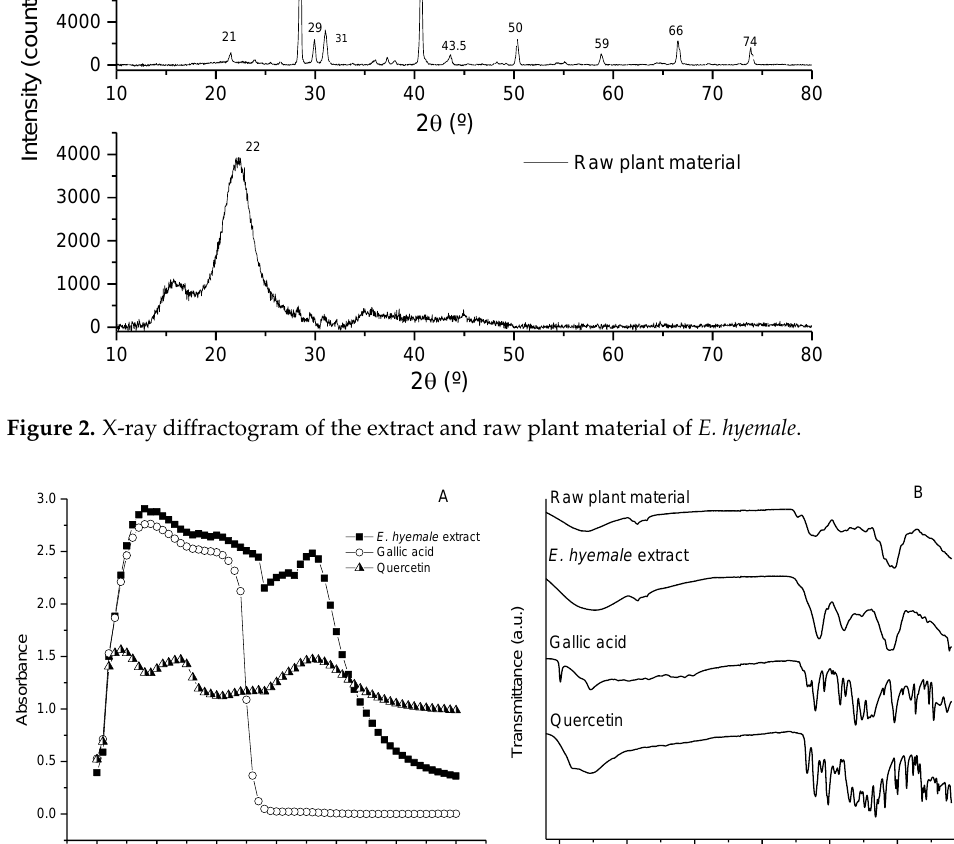
2.4. Chemical Structure of E. hyemale Extract Evaluated by UV/Vis Spectrophotometry and